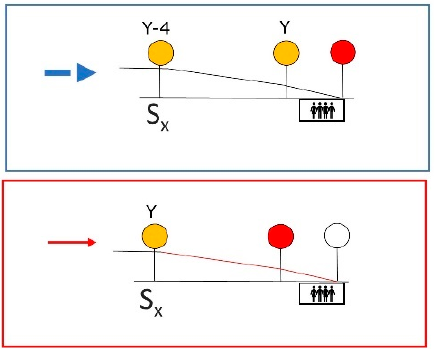
Figure 4. There can be variation in the signal aspect at a specific location. In the top approach, the first signal has aspect yellow:4 (Y-4) because the signal at the station is red and the distance between the last two signals is insufficient for a green–yellow–red sequence. In the bottom approach, the first signal is yellow because the next signal is red.